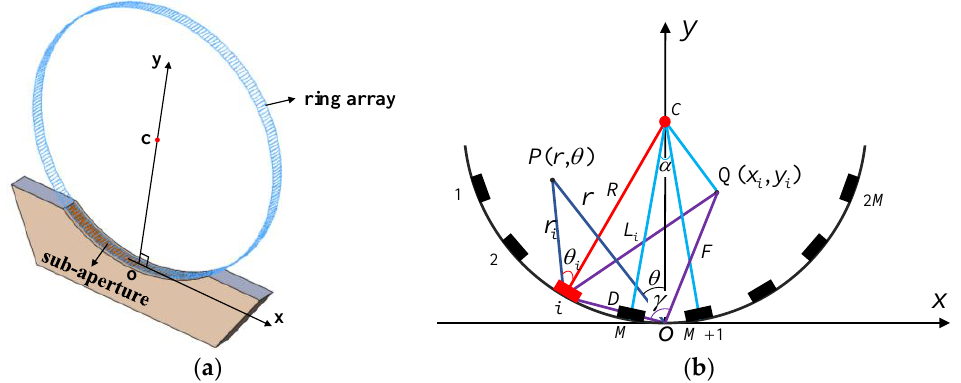
Figure 2. Schematic diagram of the sub-aperture in the ring array. ( a ) Three dimensional modeling of the ring array and the sub-aperture. ( b ) The Cartesian coordinate system on the xoy plane established for the sub-aperture.